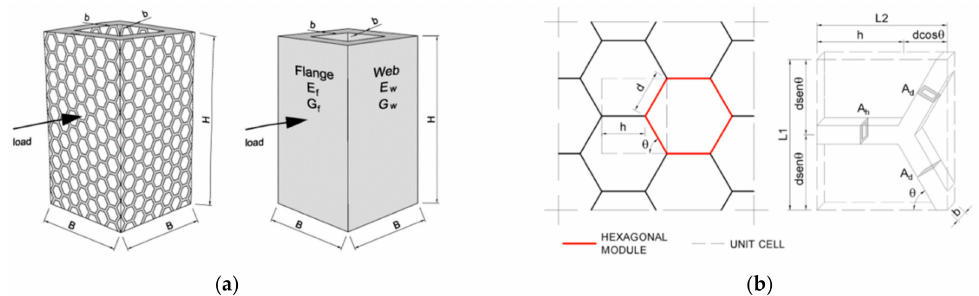
Figure 18. ( a ) Analogy between the hexagrid tube and an orthotropic solid membrane; ( b ) hexagonal module and unit cell. Used with permission from Montuori et al.